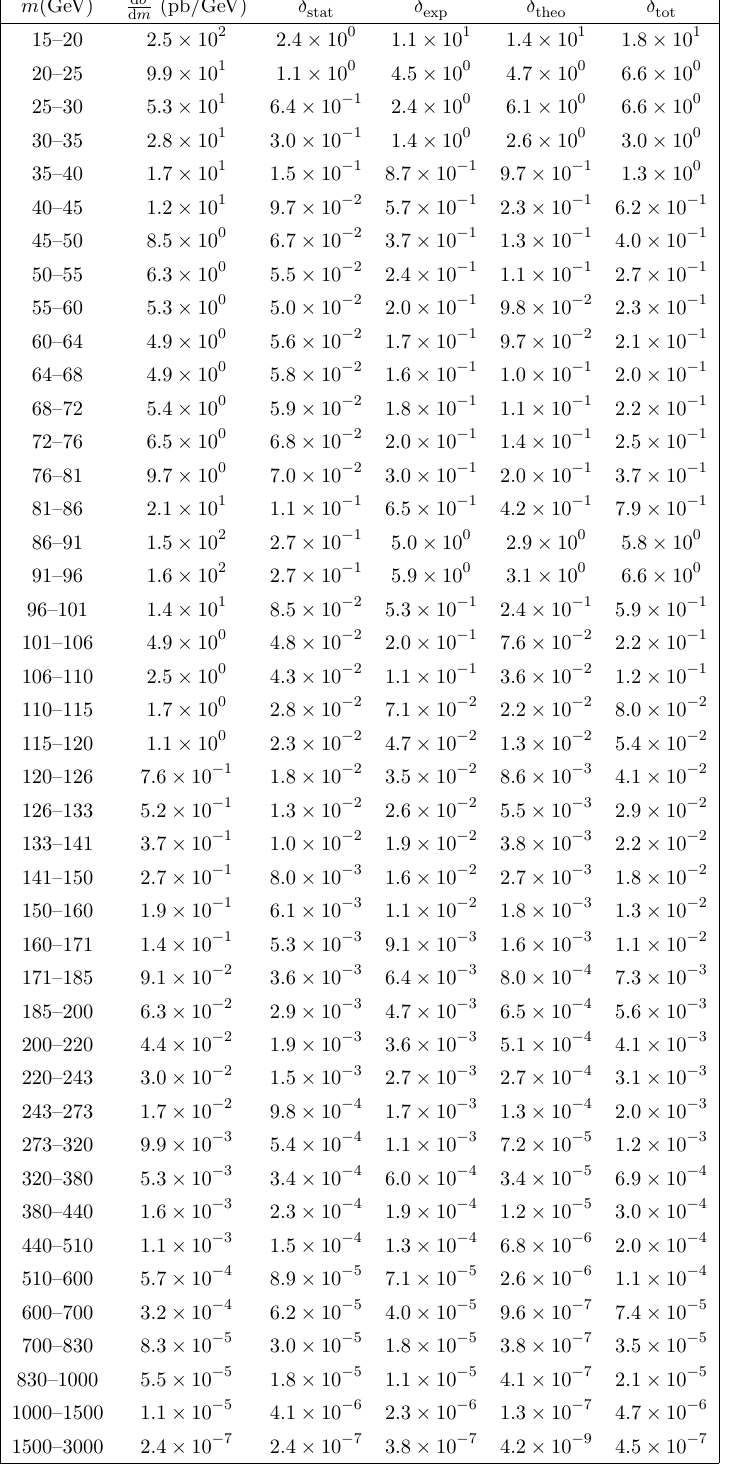
Table 3 . Summary of the measured values of d (cid:27)= d m (pb/GeV) in the dimuon channel with the statistical ( (cid:14) ), experimental ( (cid:14) ) and theoretical ( (cid:14) ) uncertainties, respectively. Here, (cid:14) stat exp theo is the quadratic sum of the three components.